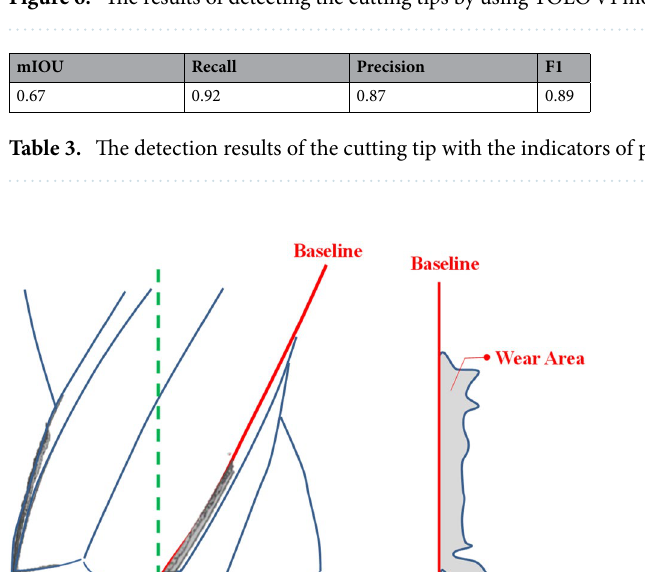
Figure 6. The results of detecting the cutting tips by using YOLO v4 model.